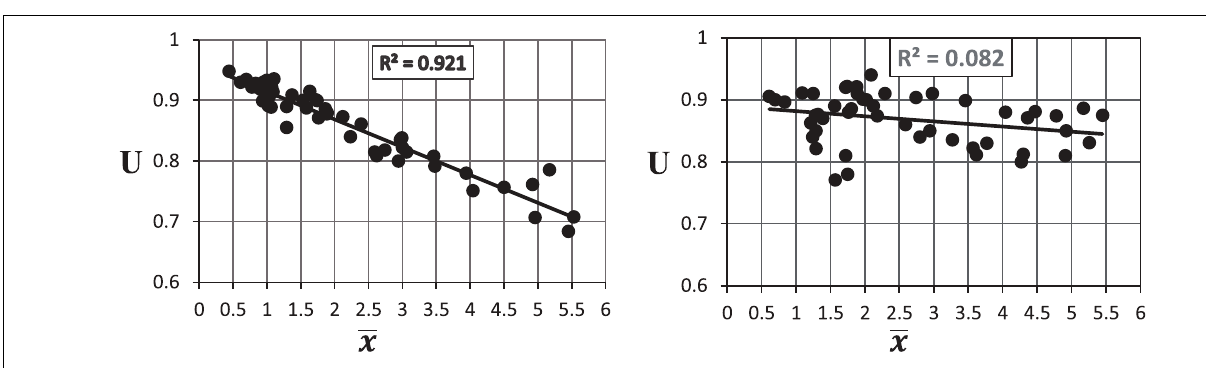
FIGURE 5 | U values for the selected W and WT sections with different connection lengths.